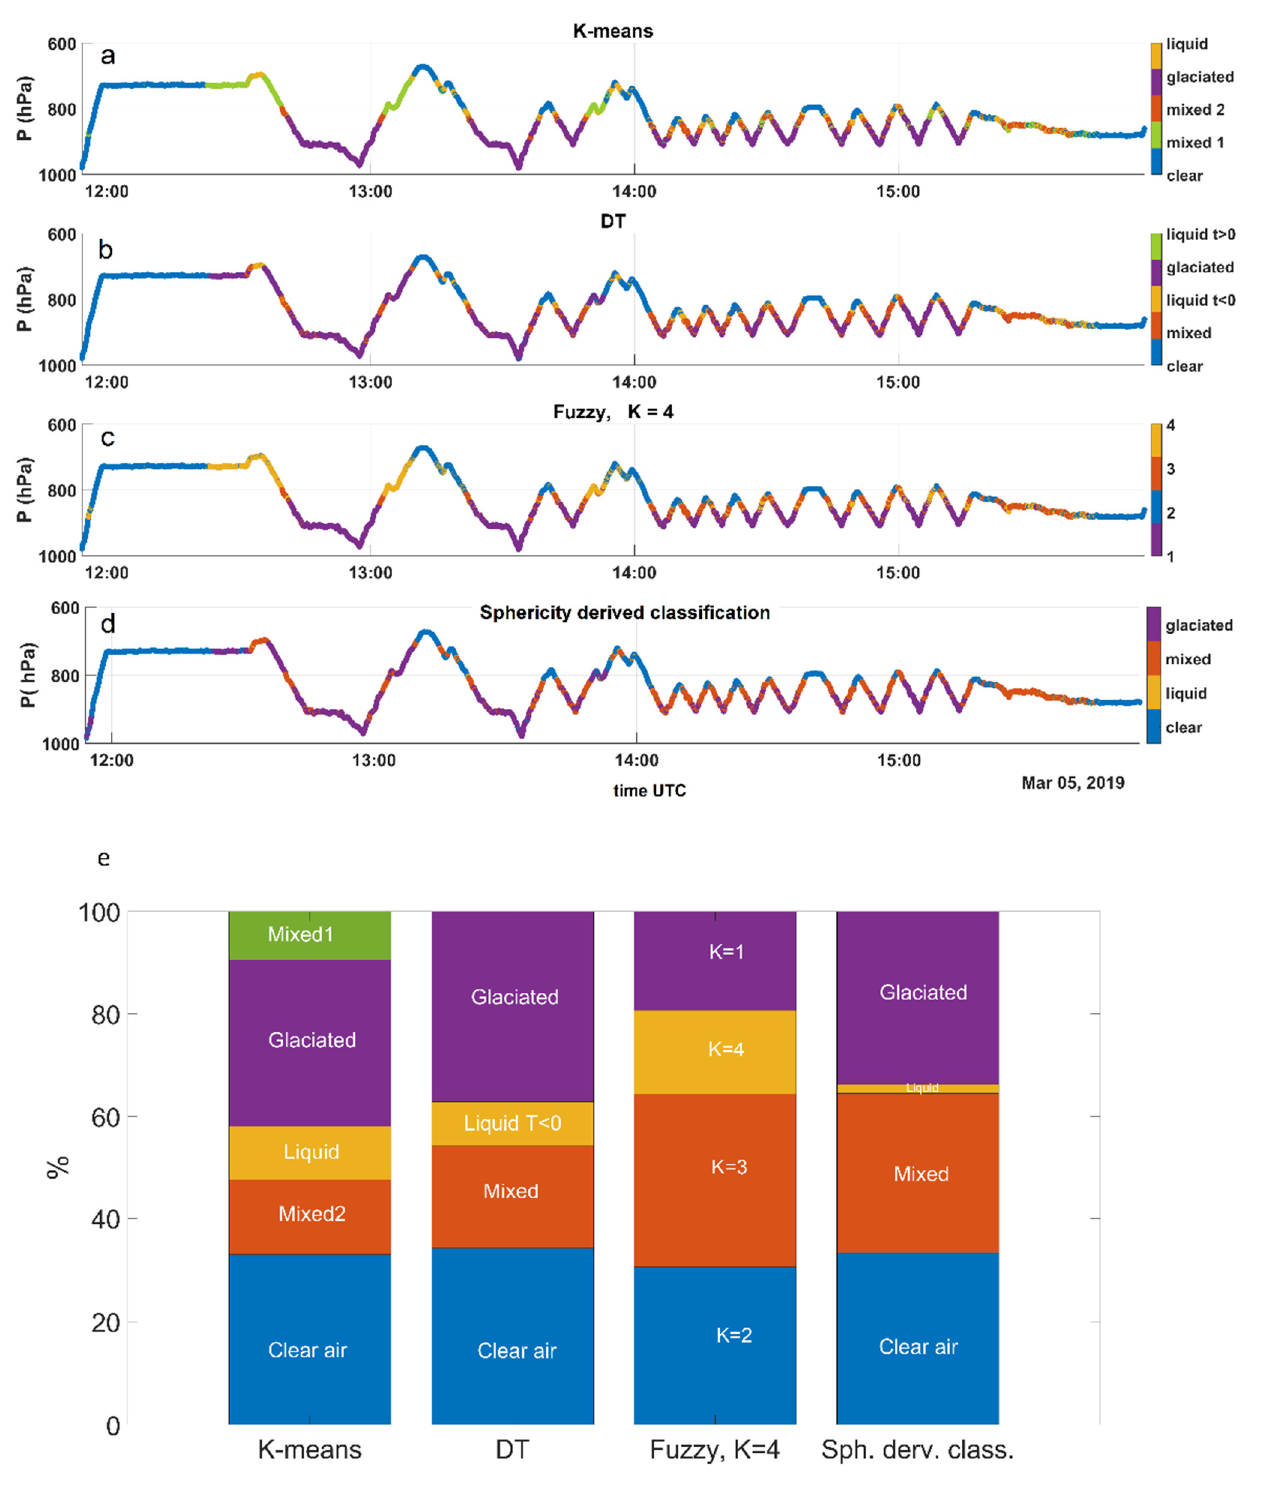
Figure 14. Time series of aircraft pressure-altitude on 5 March 2019 (F28) color-coded according to class assignments by four methods: ( a ) k-means algorithm with manual labeling; ( b ) decision tree; ( c ) fuzzy clustering without manual labeling; ( d ) sphericity derived classification. In the bottom panel, ( e ) histogram for a selected segment of the flight (11:55–15:55), illustrating the differences in the occurrence of the classes in each method.